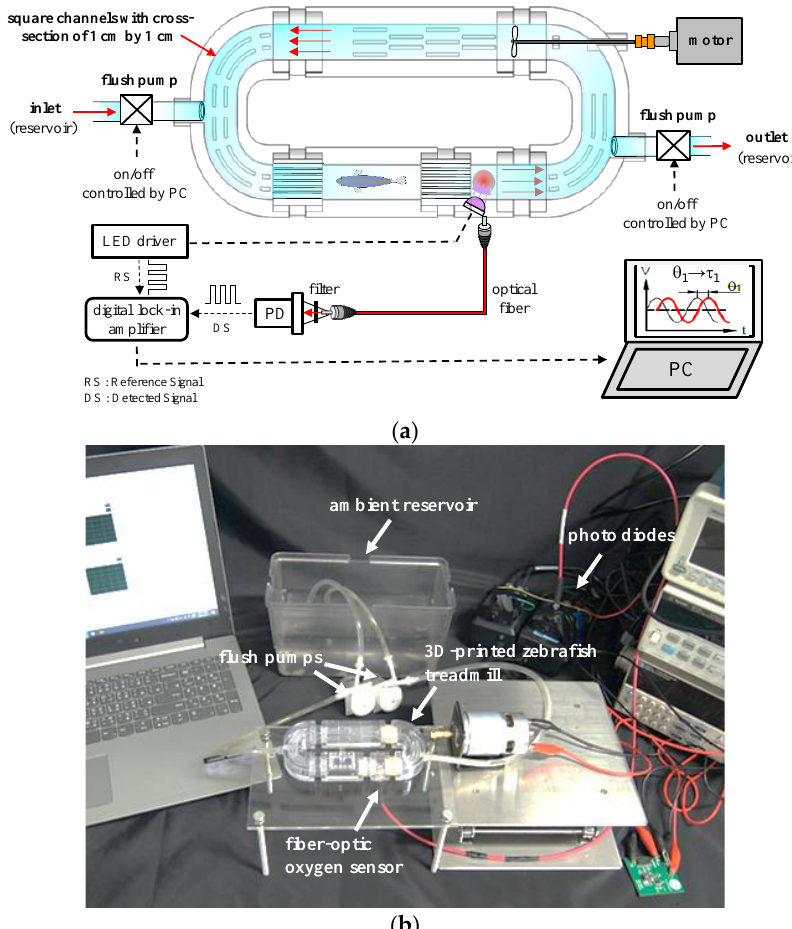
Figure 1. ( a ) Schematic and ( b ) image of the miniature intermittent flow respirometry system (mIFRS), composed of a 3D-printed, palm-sized zebrafish treadmill to provide a swimming tunnel, a fiber-optic oxygen sensing system to measure concentrations of dissolved oxygen, and a custom-made PC-based control system to automatically turn the flush pumps on and off to create a temporary closed circulating water flow. Intermittent-flow respirometry is a series of open and closed water circulation phases at a preset circulation water velocity with concomitant oxygen measurements. A single test zebrafish was placed into a 3D-printed zebrafish treadmill to evaluate its swimming ability, aerobic metabolic rates, optimal swimming speeds, and cost of transport by calculating the oxygen consumption rates of the test zebrafish.